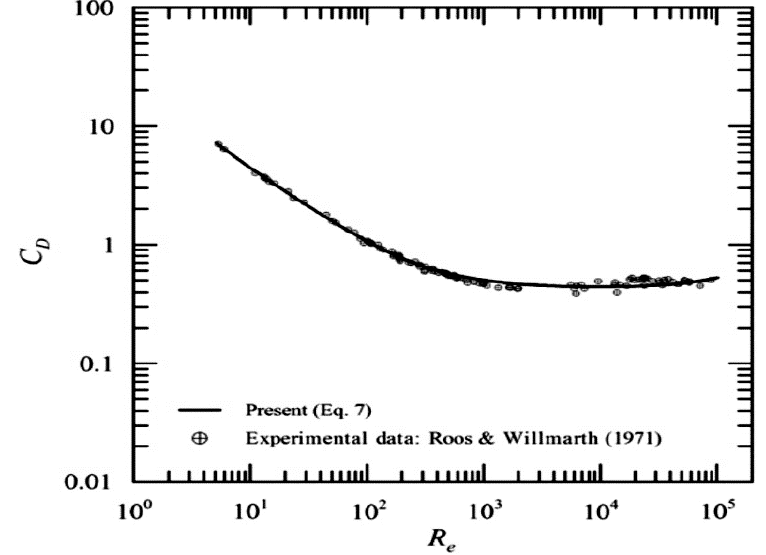
Figure 4. Drag coefficient ( C D ) of a sphere versus the Reynolds number ( R e ). We can see that the drag coefficient is constant, starting from 10 3 R e ; with an approximate value of 0.47 [37].